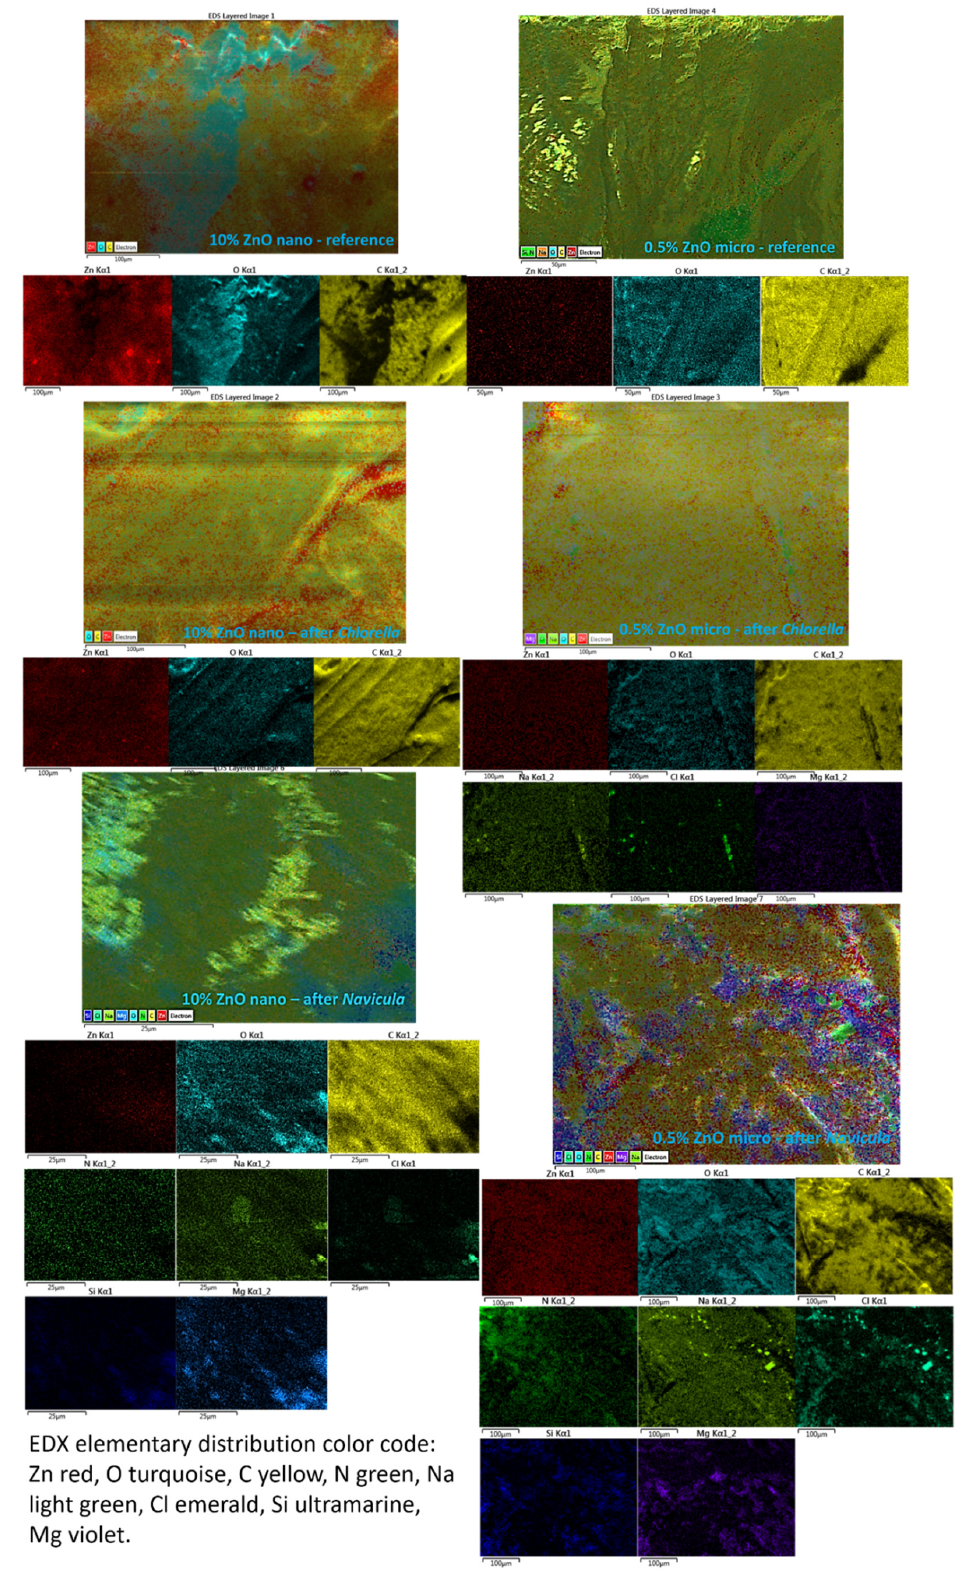
Figure 14. EDX elemental mapping of 10% nano-ZnO-ABS and 0.5% micro-ZnO-ABS, 3D printed composites (reference and after plankton exposure). Large image-composite elemental map followed by individual element mapping bellow.